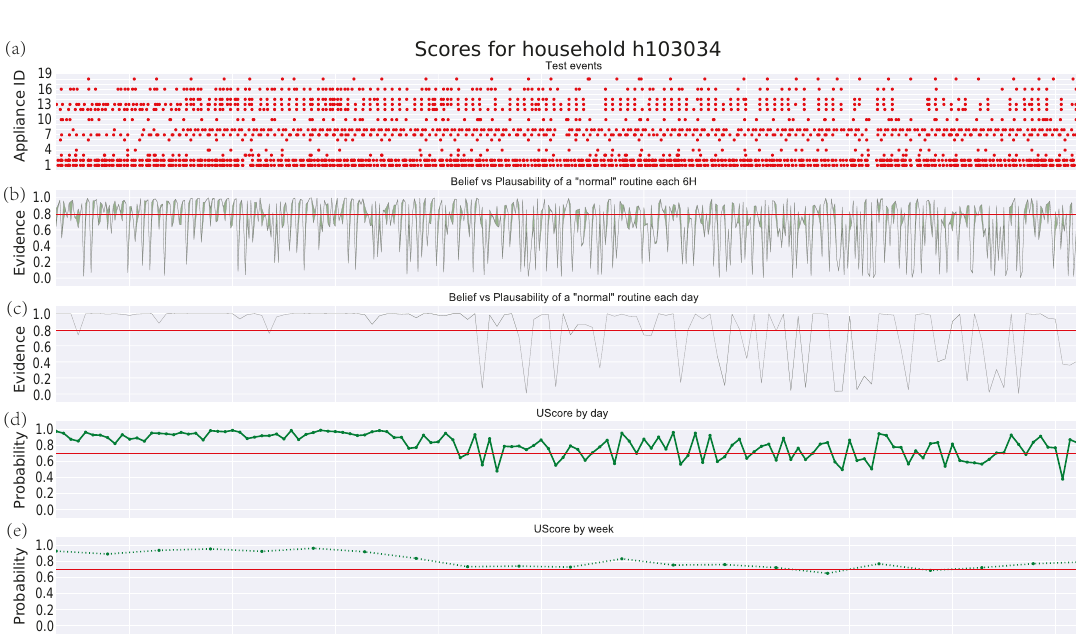
Figure 3. Score for test events in household No. 101017 from HES dataset: ( a ) Test events; ( b ) DST score every 6 h; ( c ) DST score by day; ( d ) union probability score by day; and ( e ) union probability score by week.